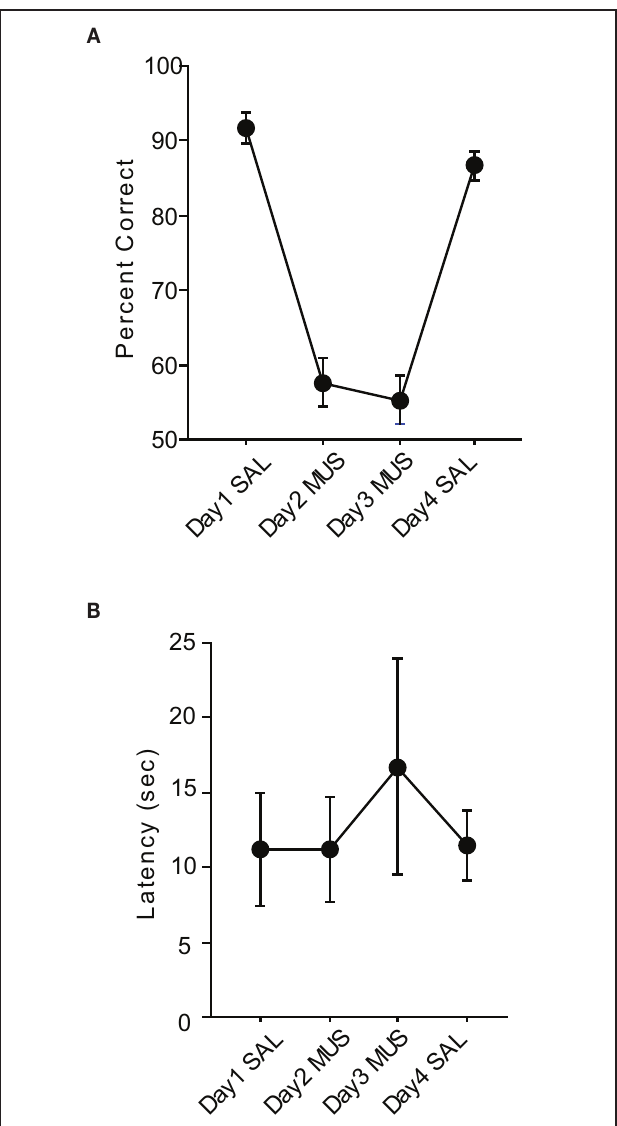
FIGURE 4 | Performance in the cVCRS task. (A) Rats with MUS injections in the hippocampi were also impaired in the cVCRS task as severely as in the pVCRS task. (B) Latency measures were not significantly different between SAL and MUS conditions. All graphs show mean ±